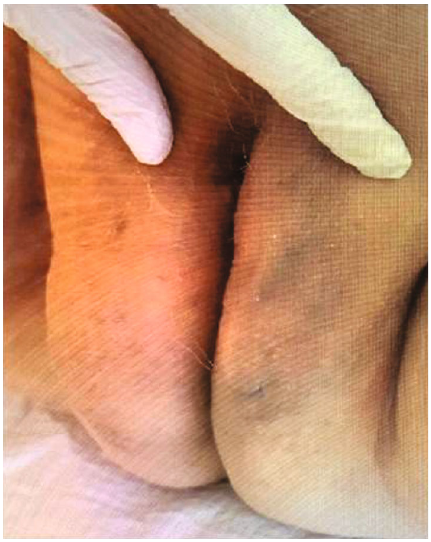
and suspicion of cellulitis.